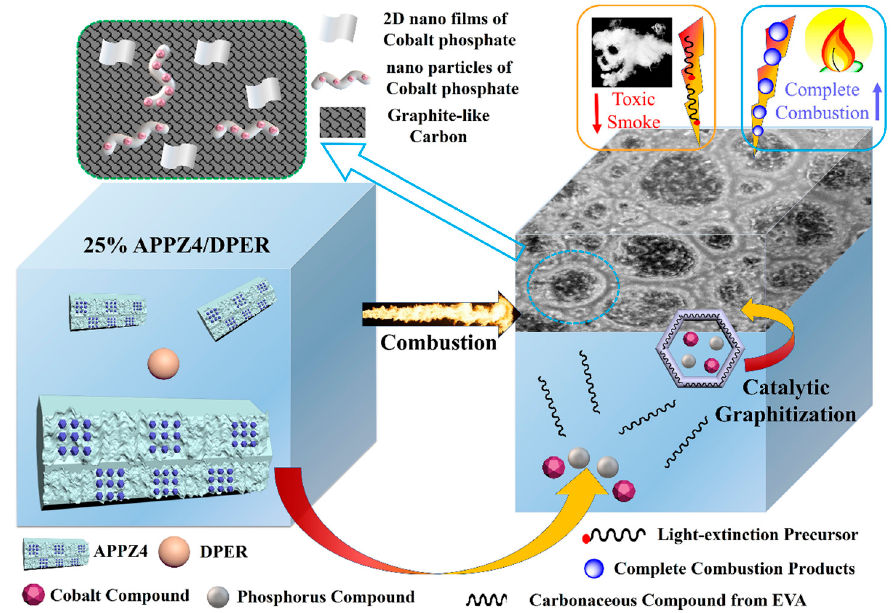
Figure 12. Illustration of the flame-retardant and smoke suppression mechanism.